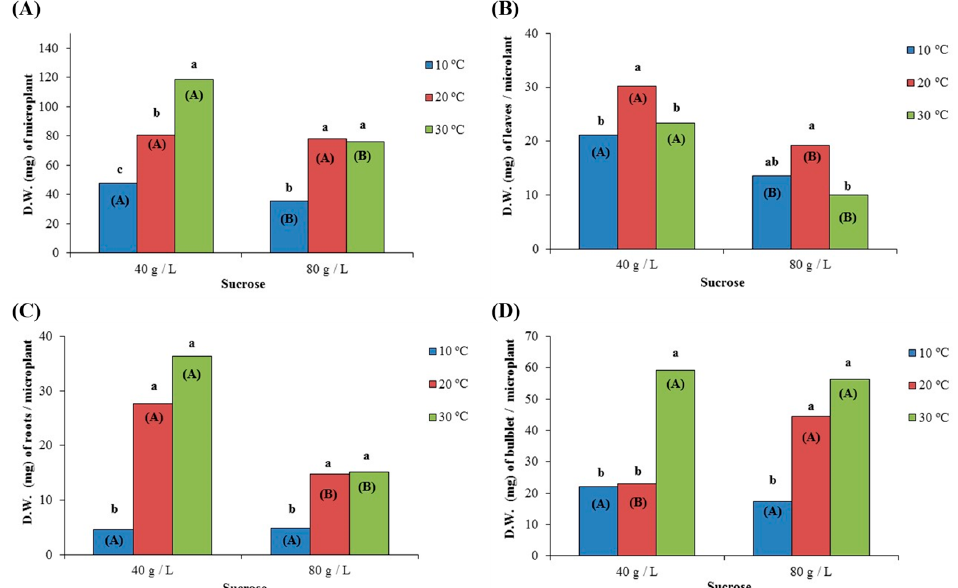
Figure 6. Effect of two different concentrations of sucrose (40 g/L and 80 g/L) at three different temperatures (10 °C, 20 °C, and 30 °C) on the dry weight (D.W. expressed in mg) of ( A ) microplant; ( B ) leaf blades per microplant; ( C ) roots per microplant; and ( D ) bulblet per microplant, after growing for 72 days in culture media. In each sucrose concentration, the same lowercase letters indicate non-statistically significant differences among the temperature treatments, according to the LSD test ( p ≤ 0.05). In each temperature, the same uppercase letters in parenthesis indicate no statistically significant differences between sucrose concentrations, according to Student’s t -test ( p ≤ 0.05).